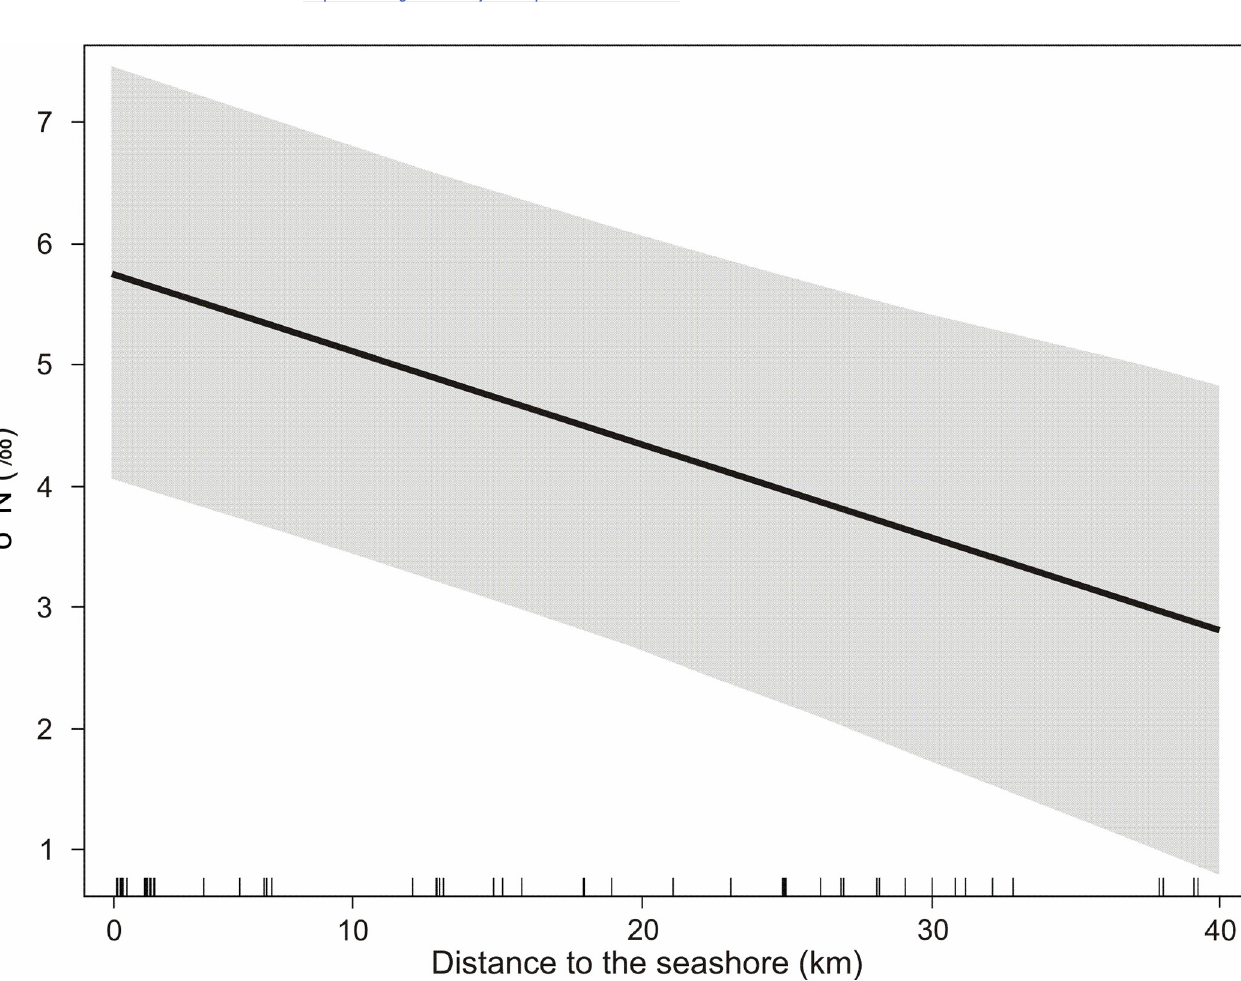
Site ID and sampling year were random factors. The top-ranked model representing the highest parsimony (the lowest AICc scores) was selected as the best model; df -number of estimated parameters; AIC c —Akaike’s information criterion with a second order correction for small sample sizes; Δ AIC c —difference in AIC c between a given model and the most parsimonious model; ωi— weight of the model.